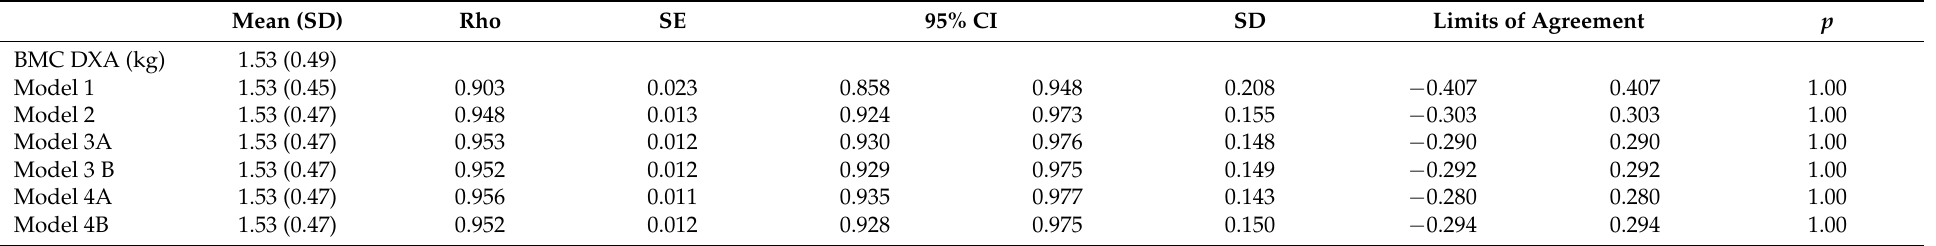
Table 5. Correlation analysis of bone mass content (BMC) dual energy X-ray absorptiometry (DXA) and predictive models in children and adolescents diagnosed with human immunodeficiency